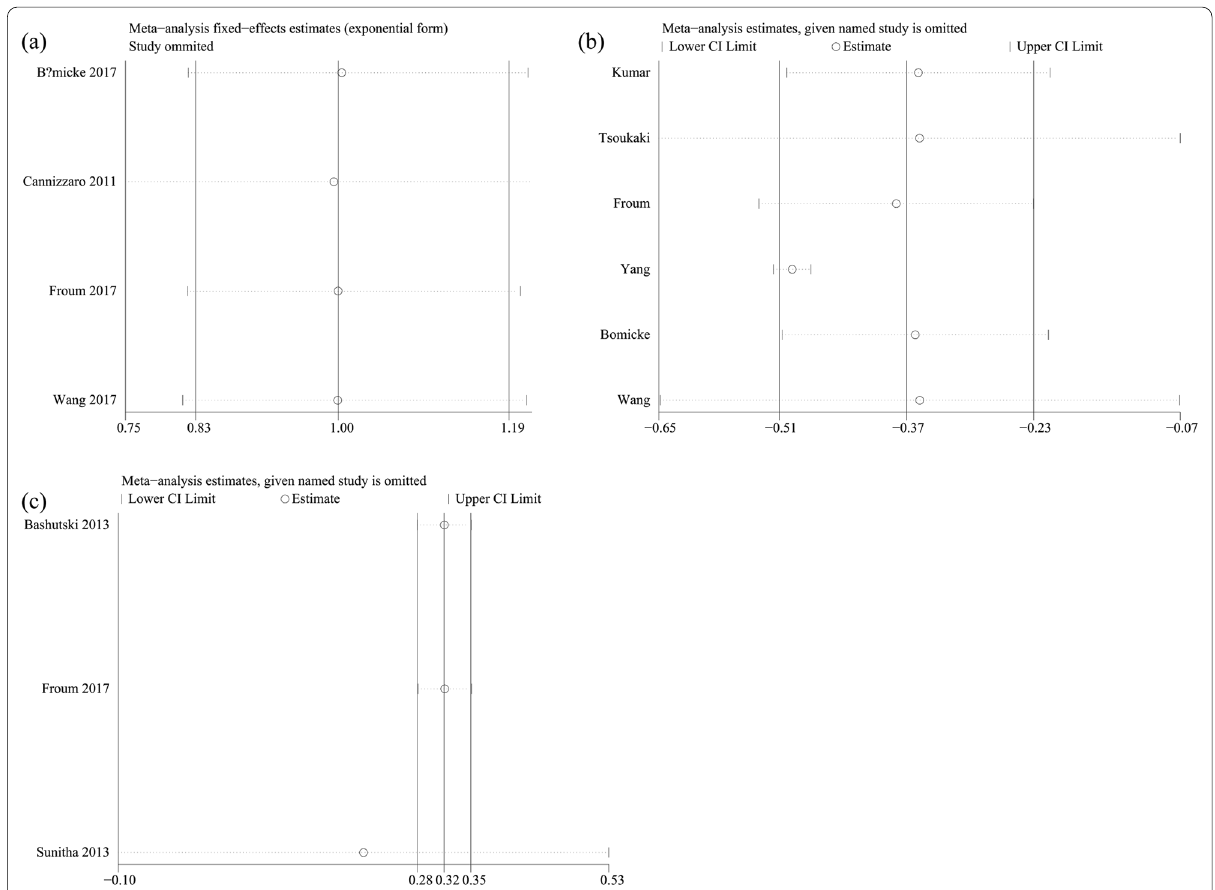
Fig. 6 Sensitivity analysis of each evaluated outcome: a SR; b peri-implant PD; c